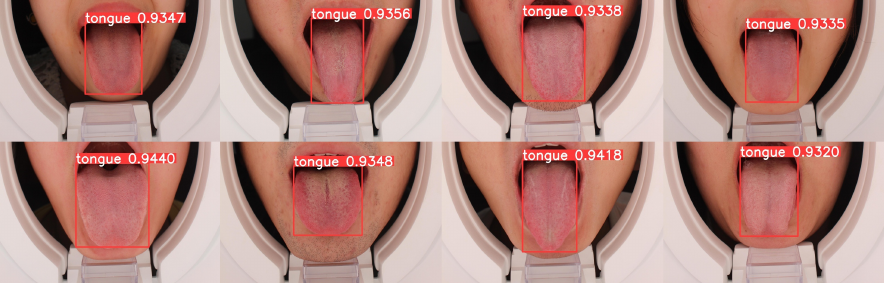
Figure 13. The detection results for the four tongue images from YOLOv5s6.